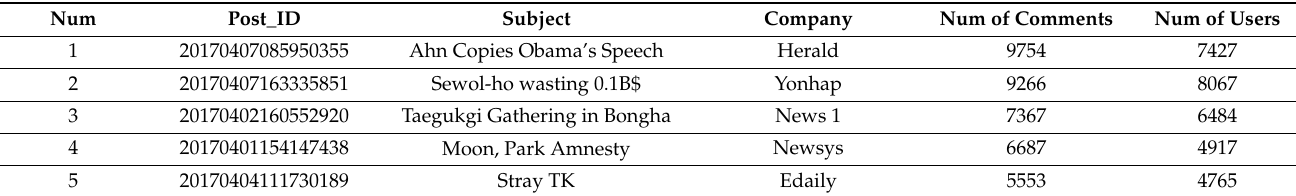
Table 1. Top 5 news articles in terms of number of comments.